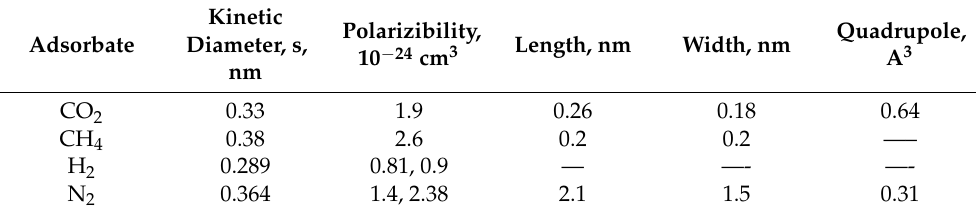
Table 1. Properties of gases used in this